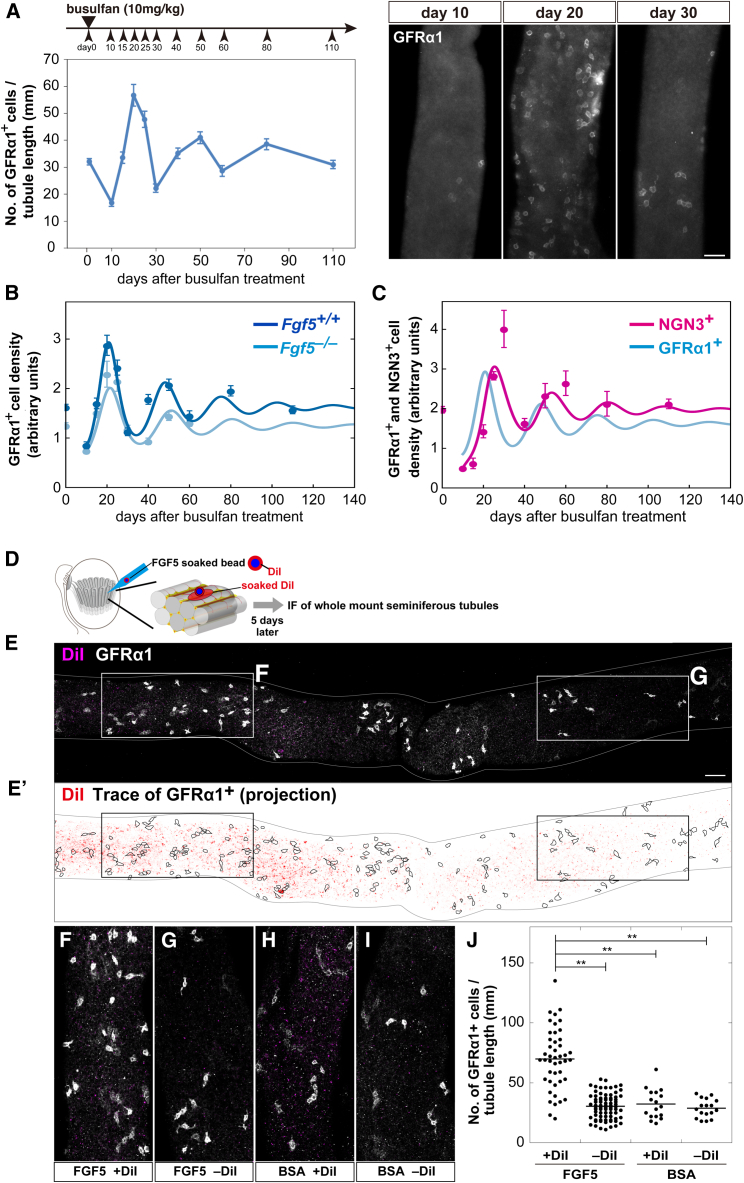
Impact of Temporal and Spatial Perturbations from Homeostasis(A) Observed kinetics of the GFRα1+ cell density following busulfan treatment in WT (left) and examples of IF images of whole-mount seminiferous tubules stained for GFRα1 (right) at the segments indicated by red circles in Figure S5I.(B) Model results (curves) compared to experimental measurements (dots) of the average GFRα1+ cell density following busulfan treatment in WT (dark blue, model fit) and Fgf5−/− (light blue, model prediction) mice. Experimental data are rescaled from (A).(C) Model prediction (magenta curve) and experimental measurement (dots) of the average density of NGN3+ (in particular, RARγ+/KIT−) cells following busulfan treatment in WT. The GFRα1+ cell density is reproduced from (B) for comparison (blue curve). Throughout, average densities ± SEM of ≥4 testes at each data point are shown.(D) In vivo transplantation of DiI-labeled/FGF5-soaked beads into testicular interstitium. DiI transfers to the proximal region of the host seminiferous tubules.(E) A whole-mount image of a part of host seminiferous tubules showing the GFRα1 (white) and DiI (magenta) signals.(E’) Trace of GFRα1+; cells in the top (E) and bottom surfaces were projected, with enhanced DiI signal overlain (red).(F and G) Magnified images of the areas indicated in (E), representing DiI-positive (F) and negative (G) regions.(H and I) Representative images of DiI-positive (H) and negative (I) regions after transplantation of BSA-soaked beads.(J) GFRα1+ cell densities (numbers contained in 1-mm-long segment) in DiI-positive and negative areas after transplantation of FGF5- or BSA-soaked beads. ∗∗p < 0.05 compared to DiI-positive areas after transplantation of FGF5-soaked beads (t test).Scale bars, 50 μm.